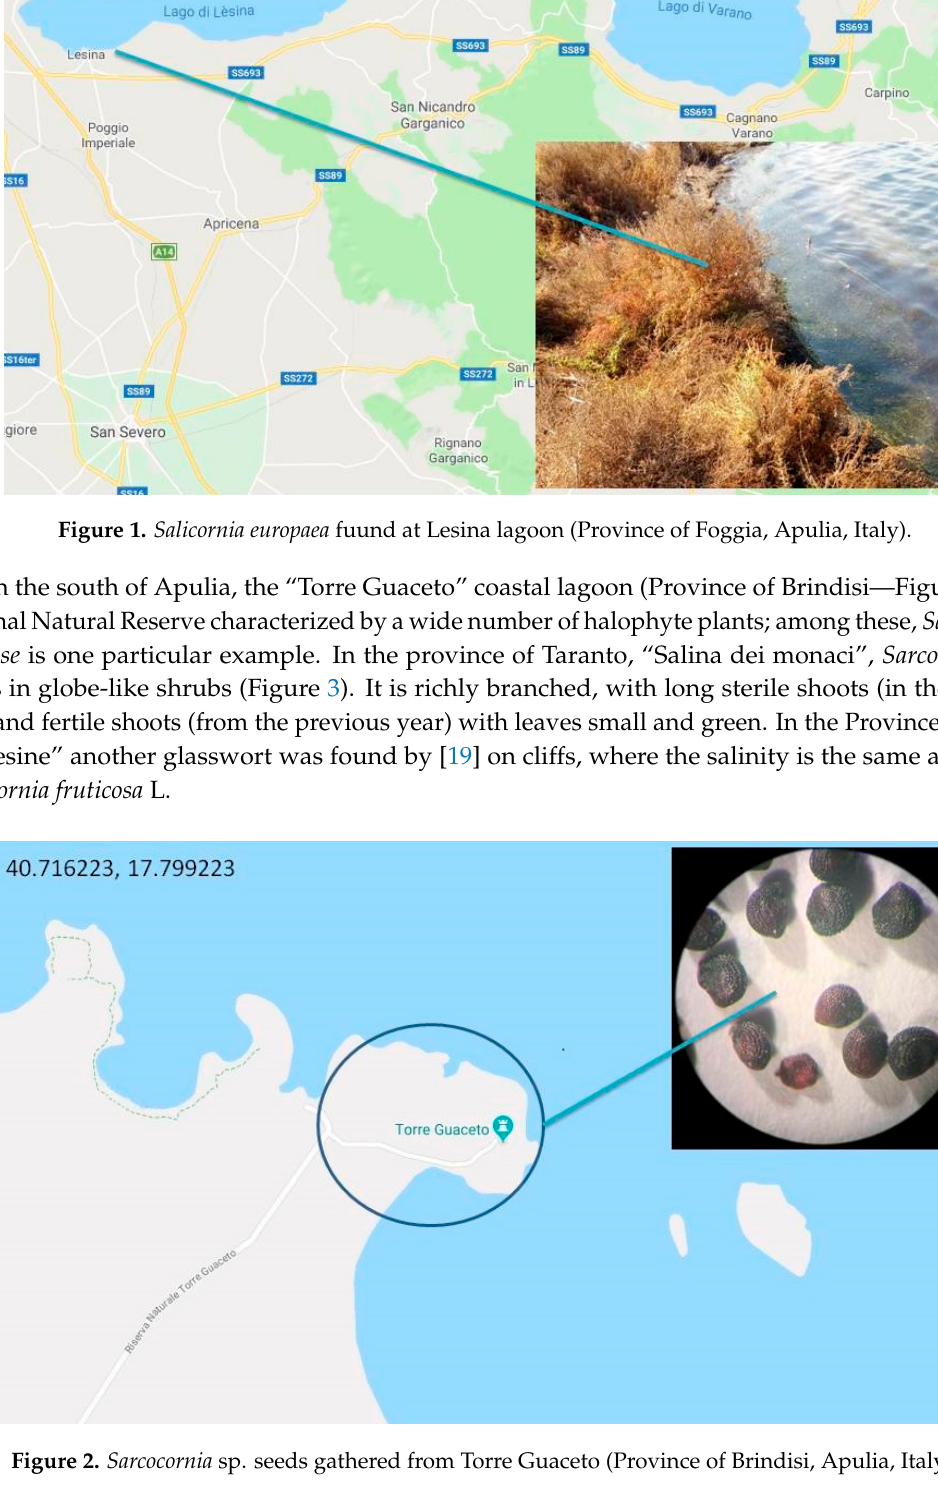
Figure 3. Adult plants of Sarcocornia sp. were harvested from Saline dei Monaci (Province of Taranto, Apulia, Italy). 3. Morphological Characteristics As glassworts are characterized by an extremely reduced morphology, they can grow prostrate, erect, or branched [13]. Figure 4a shows that the leaves are very small and the assimilatory surface is composed of succulent branches with cylindrical internodes [20]. Axillary buds on the main stem develop into primary branches which produce secondary ones [21]. Annual species are usually green, but in autumn, near the end of the cycle, the stems turn red. In Salicornia spp. flowers are aggregated in a dense terminal, spike-like thyrses composed of three flowers: one central and two lateral (Figure 4b). In Sarcocornia , these are placed in horizontal rows [12]. Glassworts differ from all other Amaranthaceae since the seeds that lack perisperm [22]. The Salicornia seed is small, ellipsoid, dark (Figure 4c) and is characterized by heteromorphism: i.e., seeds from the same plant have a difference in size, color, or shape [23]. In S. europaea L. there is a wide variation in size: 0.4–0.9 mm